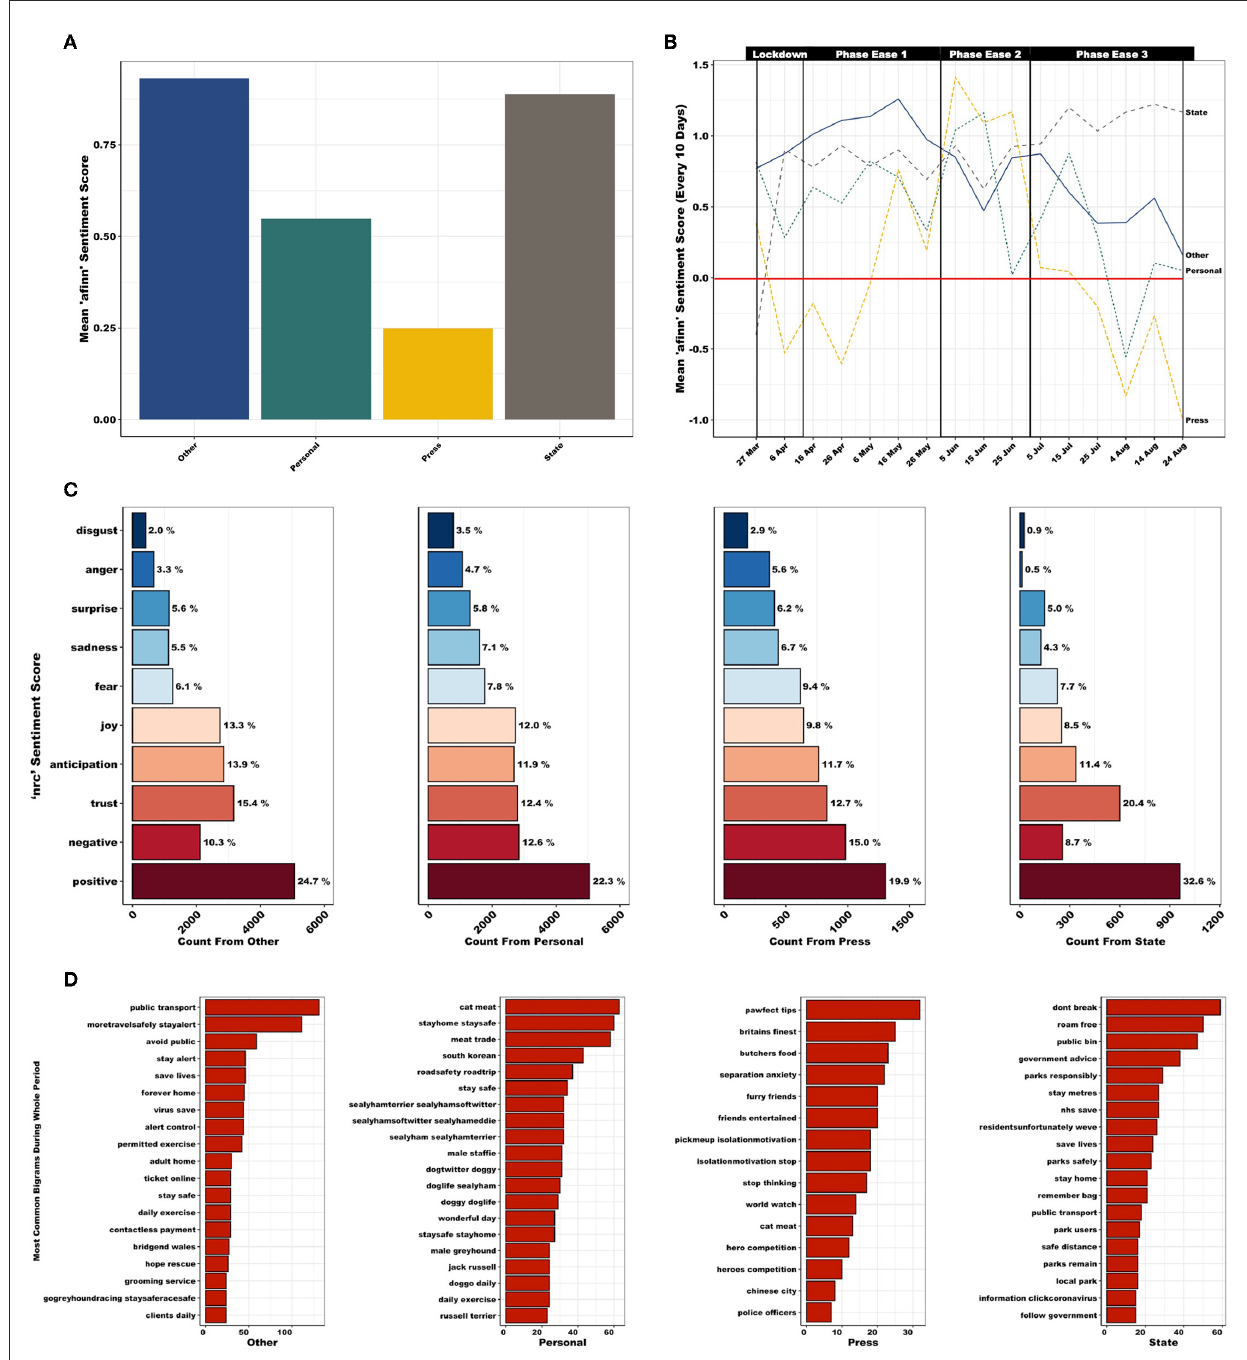
FIGURE4 (A) Mean afinn sentiment scores, across the full period (March 27th – August 22nd, 2020), differed significantly between the four sectors ( F 3,11,794 = 52.2, p < 0.001) with Personal and Press accounts exhibiting lower mean sentiment. (B) Mean afinn sentiment score, every 10 days (red line highlights zero, i.e., neutral, sentiment). A decrease in sentiment is observed for Other, Personal, and Press accounts during PE3, whereas State presents a slight increase. (C) nrc sentiment scores (%), across the full period, exhibits variation in language use between the four sectors. (D) Most frequently used bigrams used between the four sectors, across the full period. “Other” accounts focused on travel/public transport (e.g., “public transport” and “moretravelsafely stayalert”), rules/safety (e.g., “avoid public” and “stay alert”) and the practicalities of lockdown (e.g., “ticket online” and “contactless payment”). Personal accounts focused on meat trade (e.g., “cat meat” and “meat trade”), travel/public transport (e.g., “roadsafety roadtrip”), location specific topics (e.g., “south korean”) and canine focused (e.g., “doggo daily” and “doggy doglife”). Press covers a wide variety of topics, including canine focused (“pawfect tips” and “separation anxiety”), mental health (e.g., “pickmeup isolationmotivation”), meat trade (e.g., “cat meat”) and location specific topics (e.g., “chinese city”). State accounts were particularly interested in rules/safety (e.g., “dont break” and “government advice”) and outdoor space (e.g., “roam free”, “public bin”, and “parks